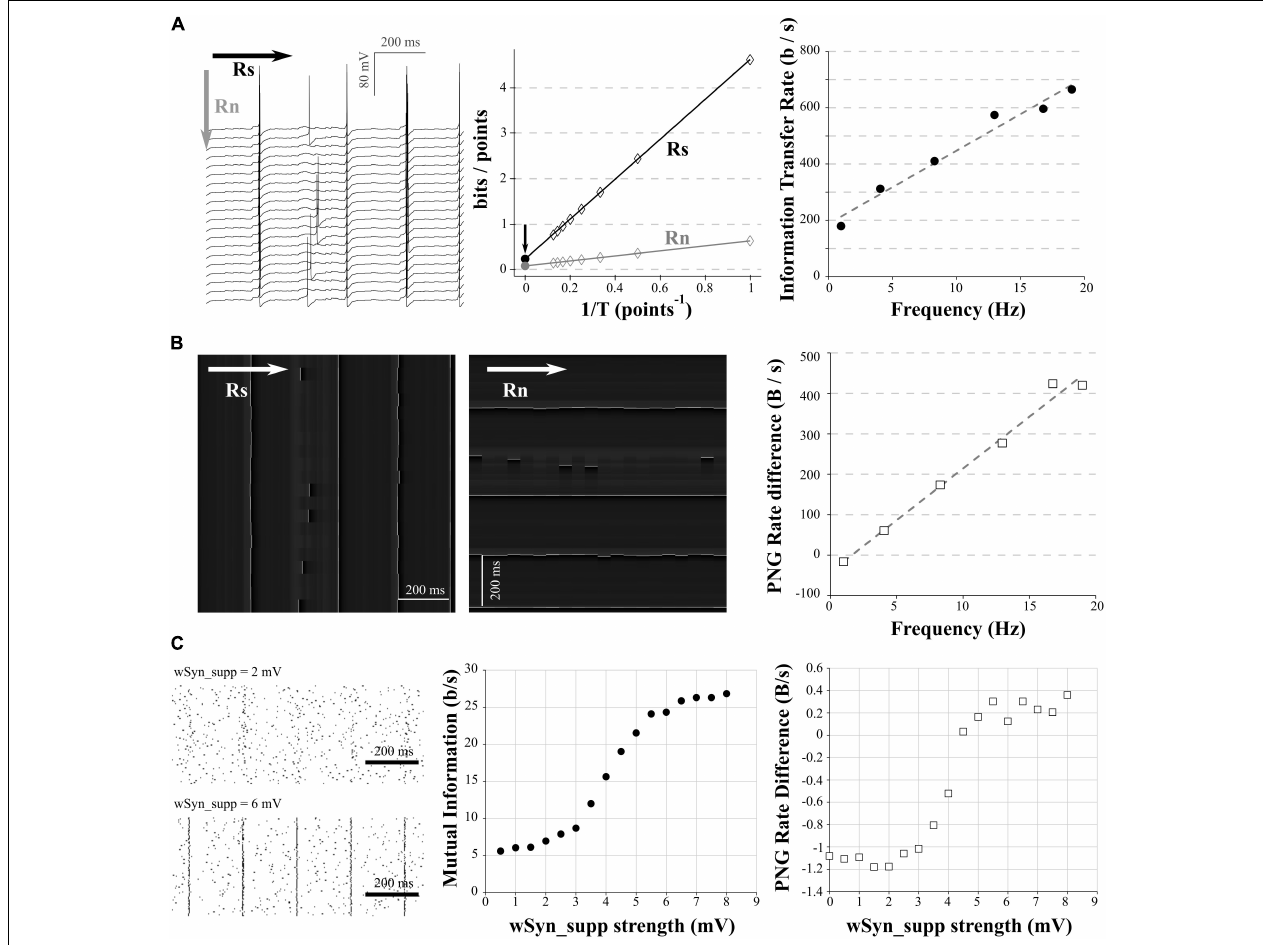
FIGURE 4 | Comparison of mutual information and PNG Rate on a neuronal model. (A) We considered different amount of synapses to obtain different spiking frequencies (from 1 to 20 Hz). For each spiking frequency, the model was run for 20 trials with the same synaptic inputs. Due to the injection of a small Gaussian noise current, we obtain variability in the spiking of the different trials. Left: example of 20 generated trials with a 5 Hz spiking activity. Note that despite the same synaptic activity between trials, the small Gaussian noise current induces variability in the spiking of the different trials. Arrows show the direction used with the quadratic extrapolations method to calculate the signal entropy ( R S ) and noise entropy ( R N ). Middle: calculation of the Entropy Rate of the Signal ( R S ) and the Entropy Rate of the noise ( R n ) for the full voltage of the cell for each condition. The Information transfer Rate R is the difference between R S and R N . Right: Information transfer Rate ( R S – R N ) between the synaptic stimulation and the neuronal activity, plotted versus the spiking frequency. This follows a linear trend ( y = 25 . 935 x + 188 . 15, R 2 = 0.97). (B) Left: Conversion of the modeled traces in (A) as a 256 gray values PNG file. As the PNG conversion algorithm is line-wise, we have to save the image a first time, divide by the number of pixels and multiply by the sampling rate to get the PNG Rate of the signal in Bytes/s (equivalent to R s in the quadratic extrapolation method; Left). Then we have to rotate the image 90 degrees, save it a second time, divide by the number of pixels and multiply by the sampling rate to get the PNG Rate of the noise in Bytes/s (equivalent to R n in the quadratic extrapolation method; Middle). Arrows show the direction of compression. Right: the subtraction of the PNG Rate of the signal and the PNG Rate of the noise follows a linear trend with the spiking frequency ( y = 25 . 55 x − 41 . 2, R 2 = 0.98). (C) The model was run with the same amount of background synapses to obtain a spiking frequency of 5 Hz. The onset of the background synapses was chosen randomly at each trial to create variability in the spiking from trial to trial. A supplementary synapse was added and stimulated the model every 200 ms. The strength of the supplementary synapse varied from 0.5 to 8 mV. 100 trial were ran for each strength of the supplementary synapse. Left: examples of rastergrams showing the impact of the supplementary synapse on our neuronal model. With a low synaptic strength (wSyn_supp = 2 mV, top), this synapse barely drives the model spiking. With a high synaptic strength (wSyn_supp = 6 mV, bottom), the neuron spiking is synchronized with the occurrence of the synapse. Middle: Information transfer Rate between the strength of the supplementary synapse and the neuronal spiking. As expected, it follows a sigmoidal behavior. Right: rastergrams were saved as PNG files, divided by the number of pixels and multiplied by the sampling rate to obtain the PNG Rate of the signal. Then, the rastergrams were rotated 90 degrees, saved again, divided by the number of pixels and multiplied by the sampling rate to obtain the PNG Rate of the noise. The difference of the 2 PNG Rates follows a similar curve as the Information transfer Rate.